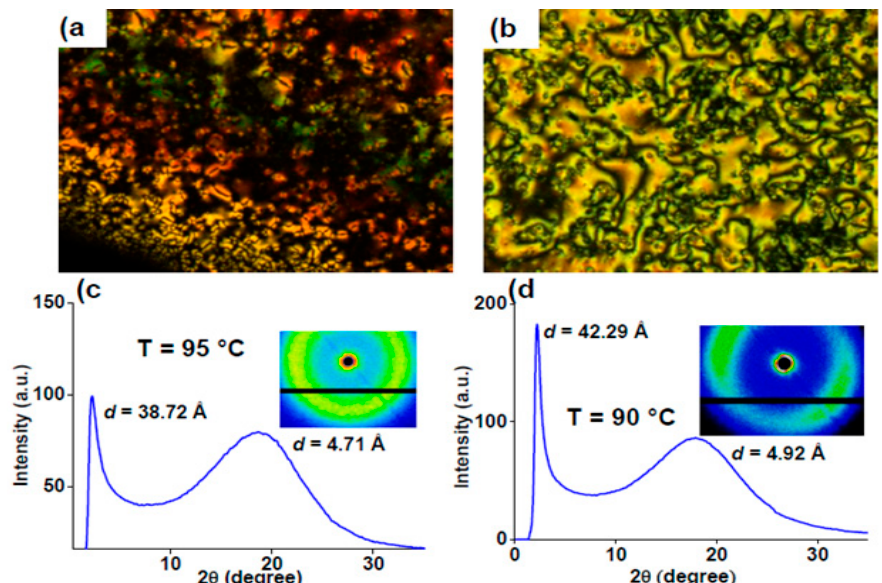
Figure 16. Textures of the nematic phase observed under POM for ( a ) compound 64 at T = 104.1 °C and ( b ) compound 65 at T = 92.8 °C; XRD profiles of ( c ) compound 64 and ( d ) compound 65 , along with their insets indicate 2D images at the specific temperature. (Reproduced with permission from ref. [154], copyright American Chemical Society 2020, https://doi.org/10.1021/acs.jpcc.9b09326).